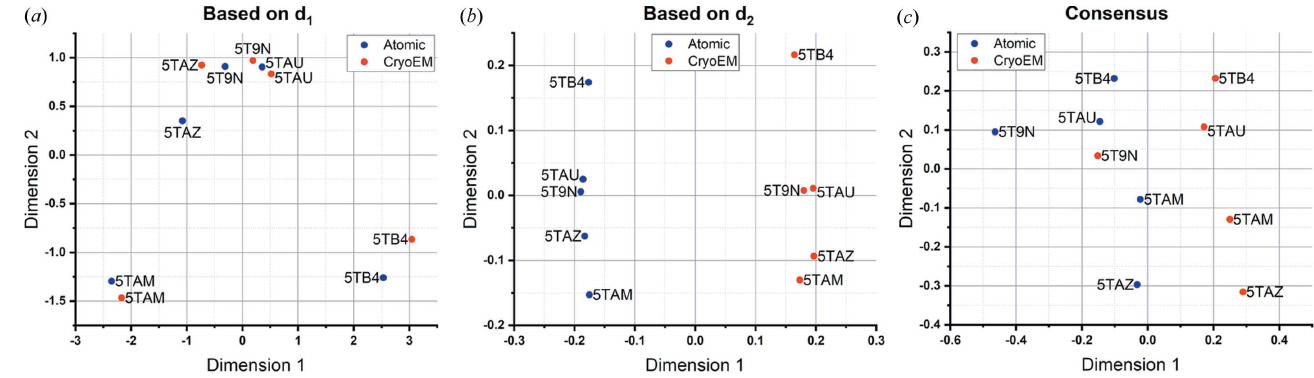
Figure 4 Results obtained after applying the Zernike3D algorithm to a set of cryo-EM maps from the ryanodine receptor 1 (RyR1). The data set was constructed in such a way that there are always two maps corresponding to the same conformational state: an experimental cryo-EM map and a cryo-EM map simulated from the atomic structure associated with the previous experimental map. ( a ) A structure map obtained when comparing experimental cryo- EM maps (red dots) and atomic models (blue dots) for RyR1 through the deformation distance d 1 . The results show that the method succeeded in recovering most of the pairs defined by the experimental cryo-EM maps and atomic structures. ( b ) A structure map obtained when comparing experimental cryo-EM maps (red dots) and atomic models (blue dots) through the correlation distance. In this case, the correlation metric fails to recover the pairs but it identifies correctly the two different map types used for this analysis. ( c ) A consensus structure map resulting from the combination of ( a ) and ( b ). The consensus provides an optimal solution that helps to identify the map pairs and the map types by keeping a similar structural relationship in the blue and red branches. In these cases, none of these approaches are sufficient for creating a meaningful structure map based on conformation alone, leading us to apply the improvement in Fig.